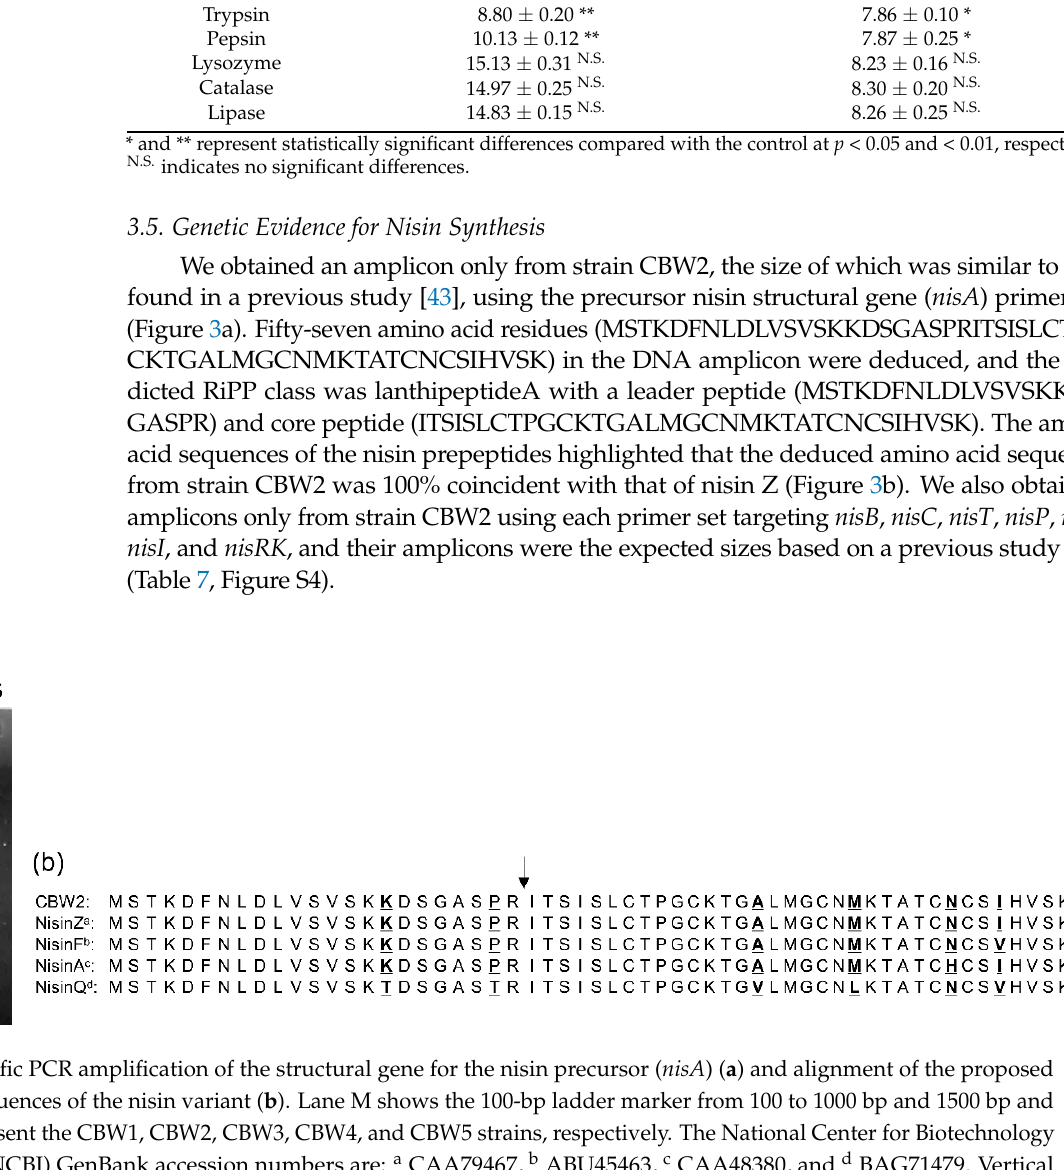
Table 6. Enzyme treatment effects on antimicrobial activity of the pH-neutralized, cell-free super- natant of strain CBW2 against Vibrio alginolyticus ATCC 17749 and Bacillus subtilis subsp. subtilis